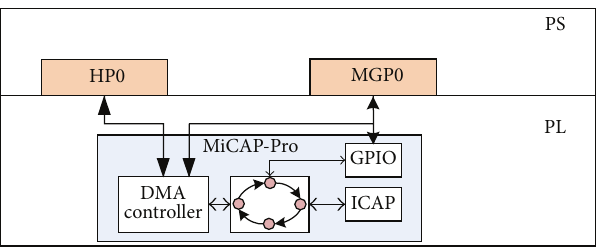
Figure 5: MiCAP-Pro architecture on the